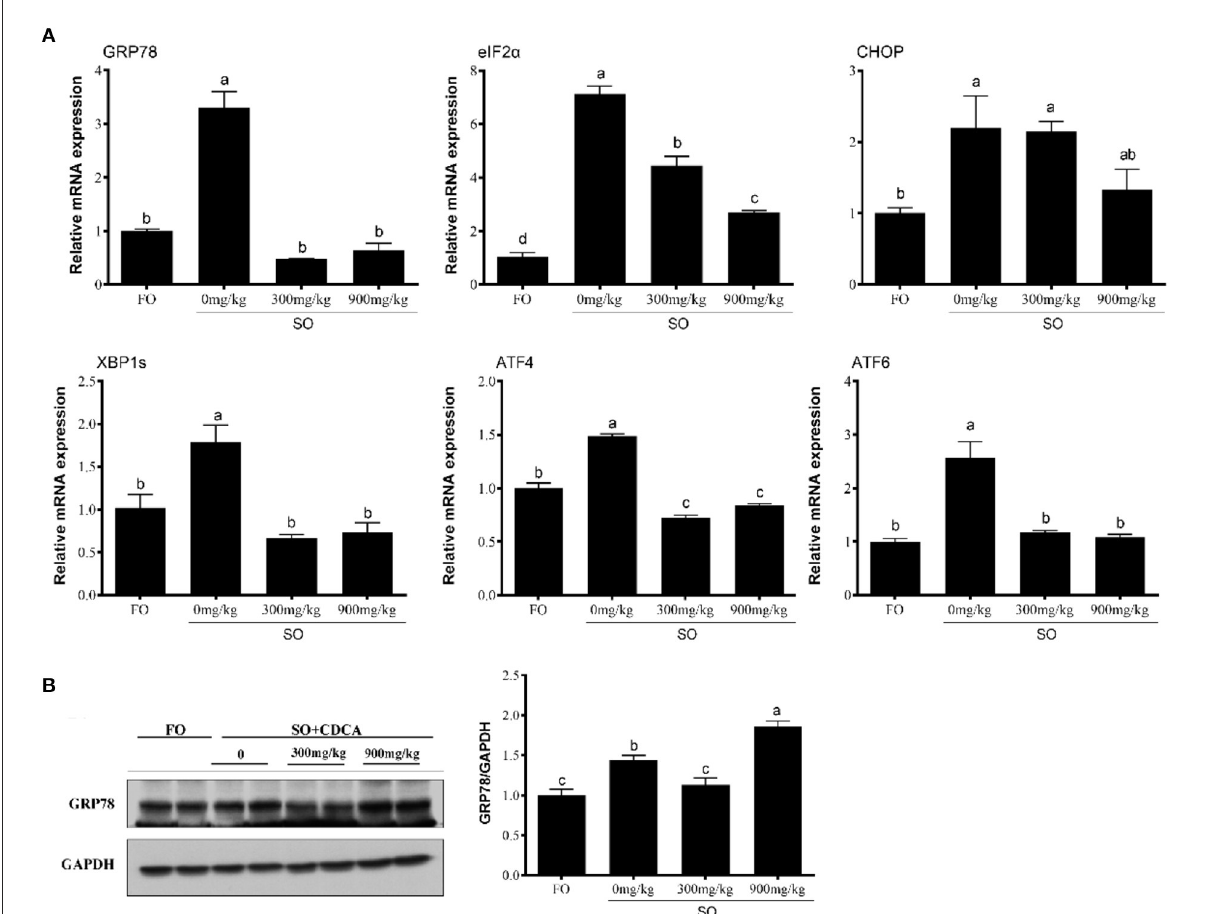
FIGURE1 Expression of (A) ER stress-related genes and (B) GRP78 protein levels in the head kidney of fish after SO feeding and CDCA supplementation. The significance was analyzed by one-factor ANOVA and Duncan’s Multiple Range Test (means ± SEMs; n = 3). Means without the same label were considered different, P <